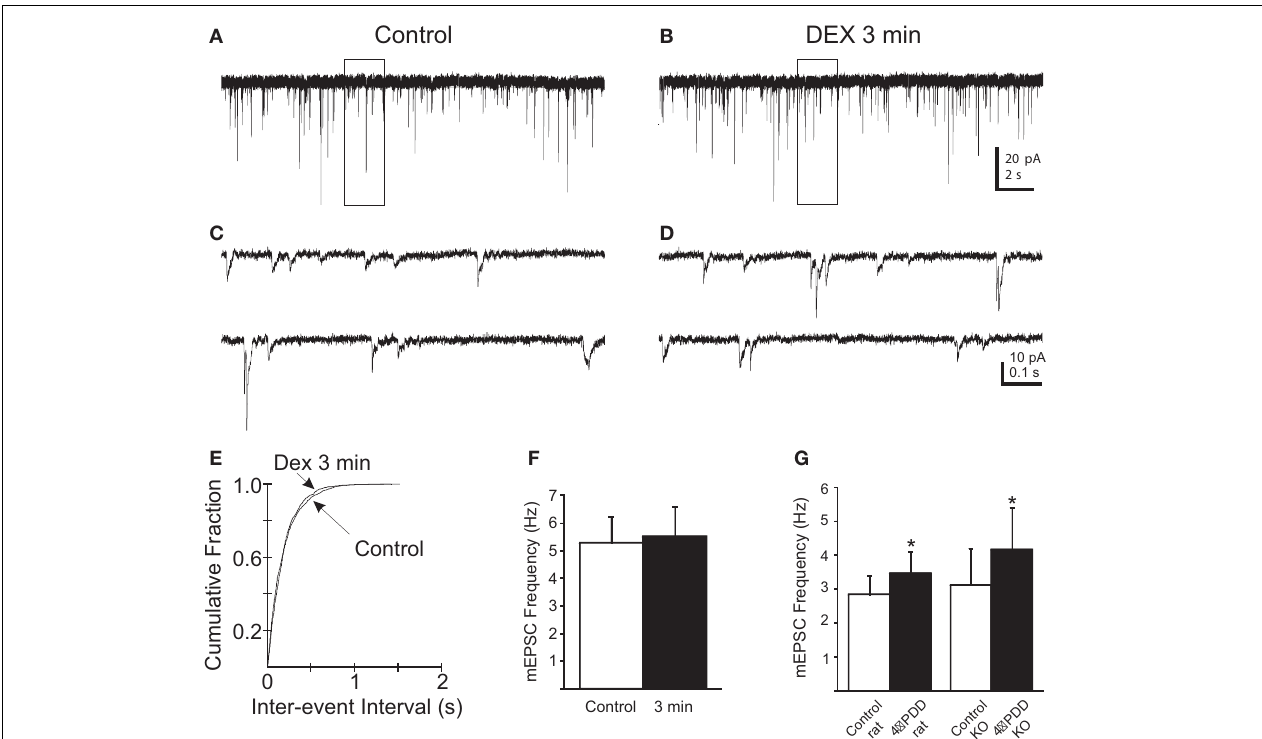
areas in the traces shown in (A,B) . (E) Cumulative probability plots of inter-mEPSC interval distribution from the same cell showed no significant increase at 3min in mEPSC frequency ( p < 0.02; K–S test). (F) No change in group means in mEPSC frequency after by 10 µ M DEX at 3 and 9min ( n = 5; p > 0.05; ANOVA,Tukey’s). (G) 4- α -PDD (1 µ M), a selectiveTRPV4 receptor agonist, increased the mEPSC frequency in gastric-related preautonomic PVN neurons from rat ( n = 4) andTRPV1 knockout mice ( n = 6; p < 0.05; t -test).